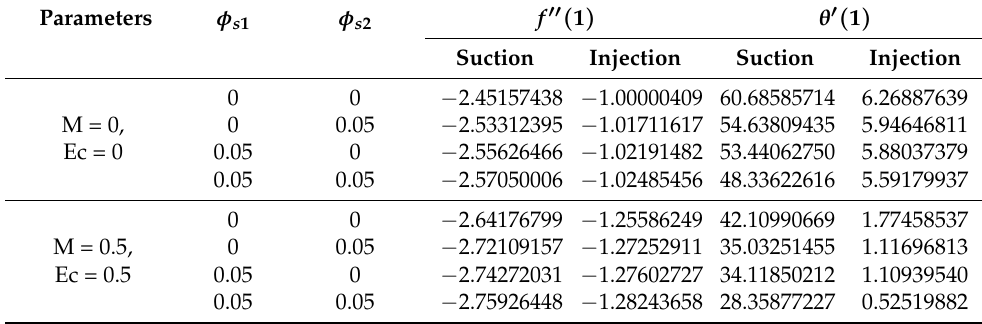
Table 8. Estimation of f (cid:48)(cid:48) ( 1 ) and θ (cid:48) ( 1 ) for different physical parameters.